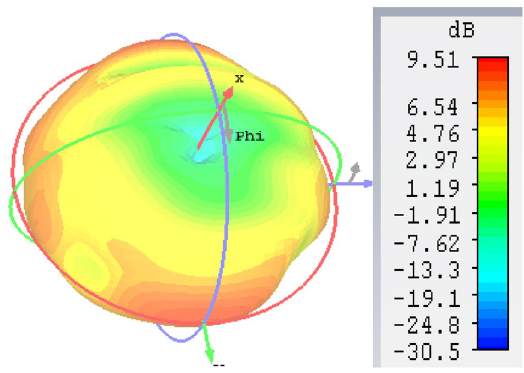
Fig. 14 Radiation pattern of L shaped graphene